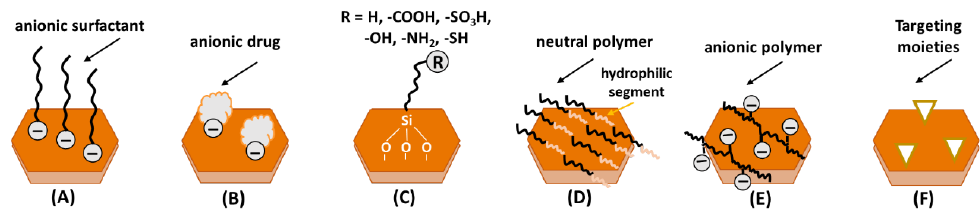
Figure 12. Strategies to modify the LDH surfaces through electrostatic or covalent linkages: ( A ) hy- drophobization of surfaces by anionic surfactants; ( B ) hydrophobization of surfaces by anionic drugs having hydrophobic groups; ( C ) surfaces modification by silanization reaction; ( D ) surface modification with neutral polymers having hydrophobic and hydrophilic segments; ( E ) surface modification with charged polymers; and (F) surface functionalization with targeting molecules.